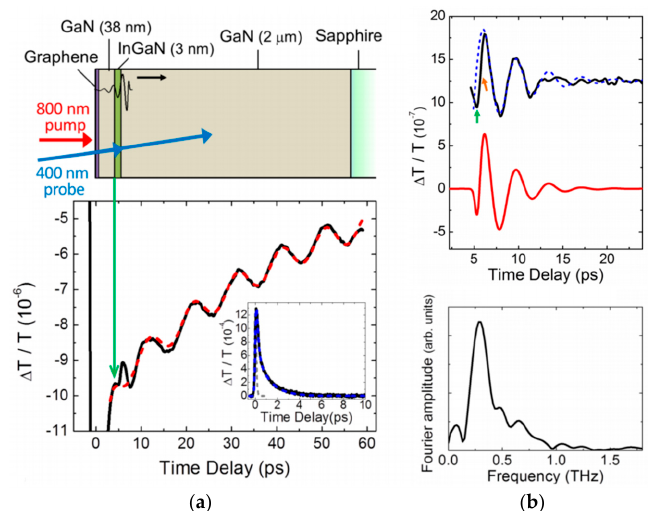
Figure 11. ( a ) (top) Schematic representation of a graphene monolayer deposited on a GaN/InGaN/GaN quantum well heterostructure. (bottom) Corresponding time-domain signal in black whose oscillating components are dominated by a Brillouin oscillation, evidenced as a dashed red line, related to the propagative CAP wave. ( b ) (top) In black, transient signal at the quantum well (indicated by a green arrow in ( a )) after removal of the previously identified Brillouin oscillation revealing the CAP waveform. Modeled waveform, see main text for details, in red slightly differs from a simple damped oscillation presented as a dashed blue line. (bottom) Corresponding spectrum. Reprinted with permission from [248]. Copyright ©2014, American Chemical Society. Nanomaterials 2020 , 10 , x FOR PEER REVIEW